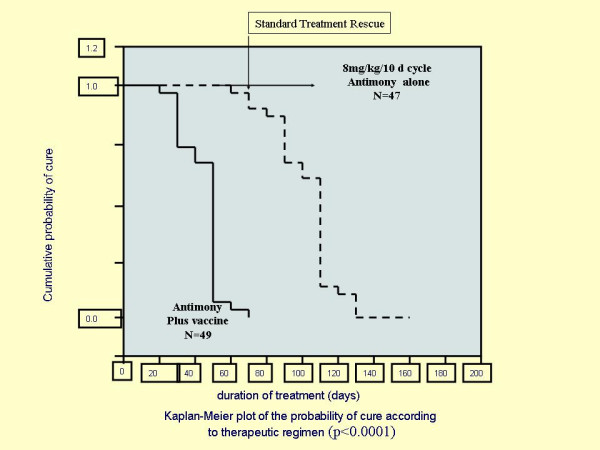
Patients received daily injections of low dose antimonial + killed vaccine for 10 days followed by 10 day rest (one cycle). After 4 cycles combined treatment cured all patients vs. 8% in low chemo alone. Combined treatment significantly reduced drug dose, cost and time to cure. The vaccine was registered in Brazil. Adopted from Machado-Pinto J. et al. Int. J. Dermatol. 41:73-8, 2002. with permission from Oxon Blackwell Pub. .